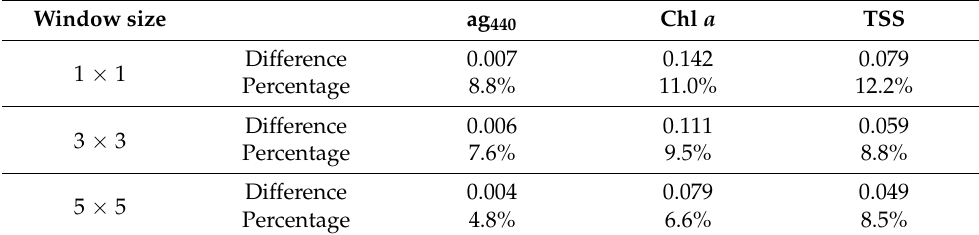
Table 6. Differences under different window sizes.